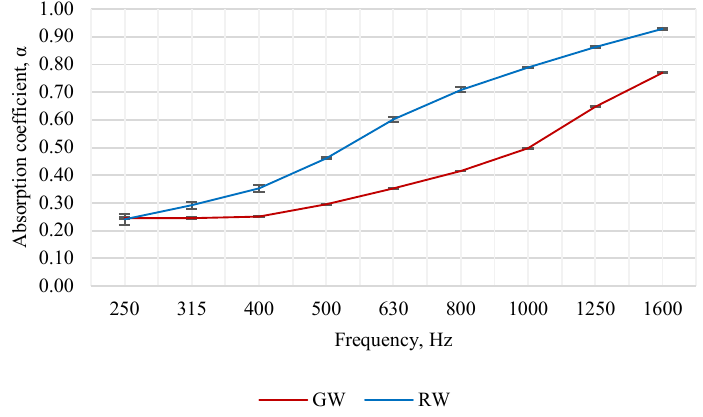
Fig. 5 . Comparison of two conventional materials: rock wool vs. glass wool